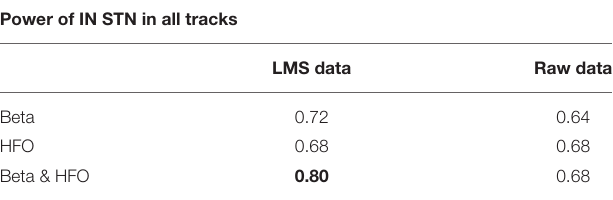
TABLE 2 | Prediction rates of classifier.